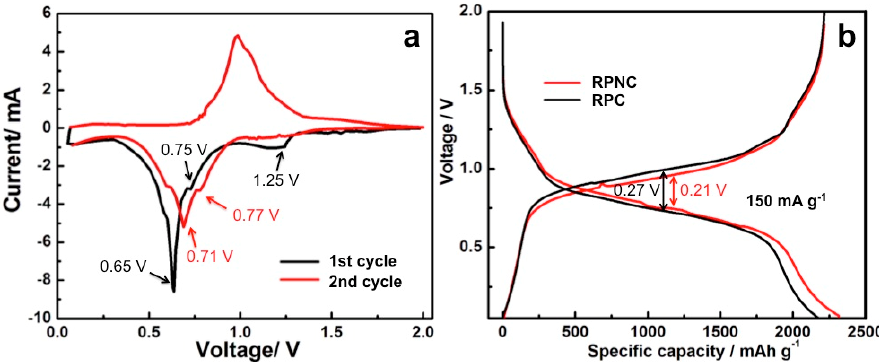
Figure 5. ( a ) The initial two cyclic voltammetry curves of RPNC composite at sweep speed of 0.2 mV s − 1 ; ( b ) the second charge-discharge profiles of RPNC and RPC at the current density of 150 mA g − 1 .